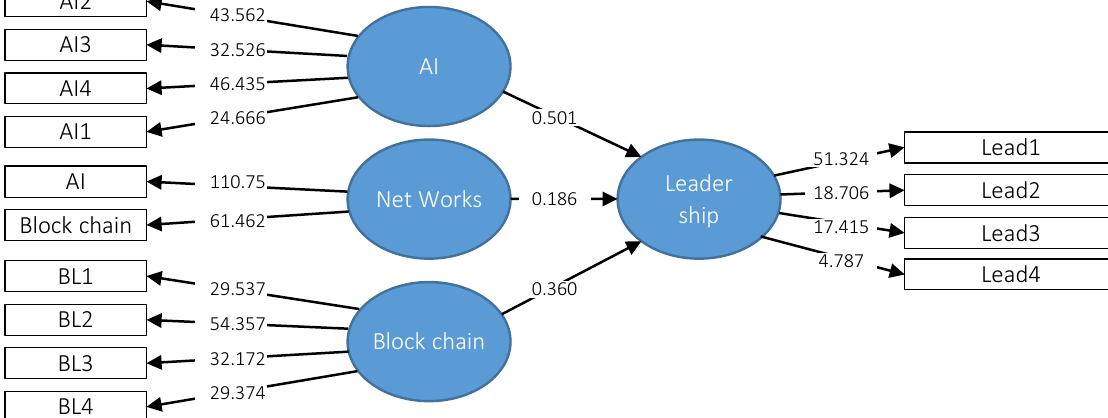
Figure 3. Employing network strategic capabilities on leadership